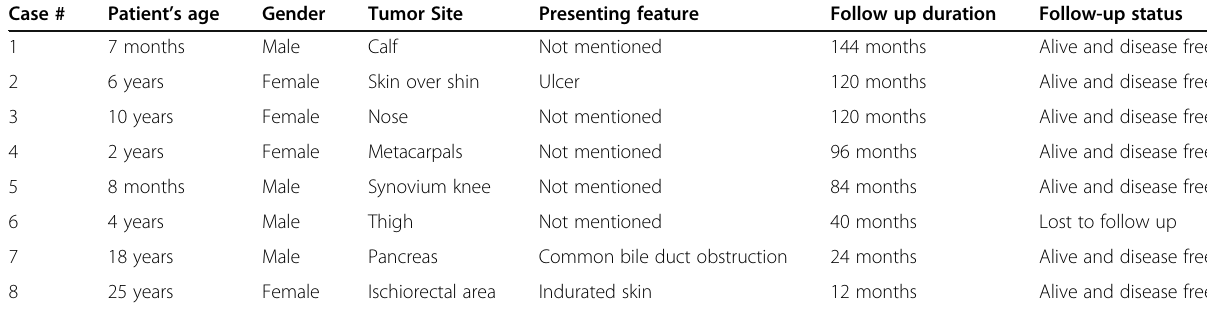
Table 1 Summary of clinical features and follow up information of KH patients ( n = 8) Case